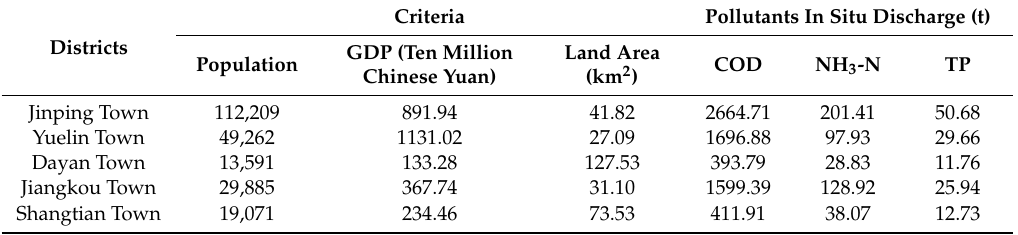
Table 3. The criteria statistics and in situ discharges of pollutants of districts in the Xian-jiang watershed (2015). COD, chemical oxygen demand; NH 3 -N, ammonia nitrogen; TP, total phosphorus; GDP, gross